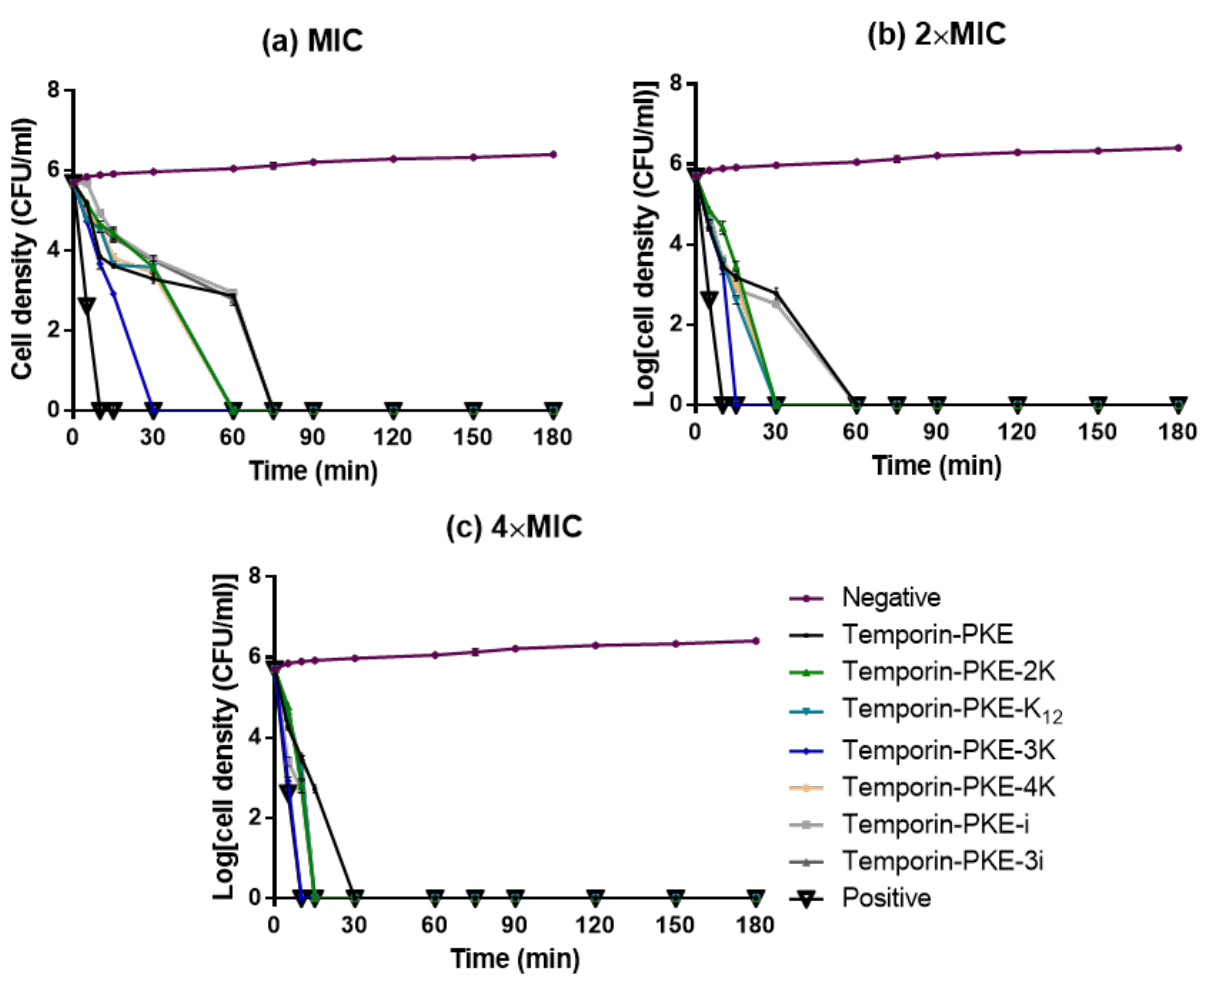
Figure 8. The kinetic time-killing curves of temporin-PKE and its analogues against S. aureus at the concentrations of ( a ) 1 × MIC, ( b ) 2 × MIC, and ( c ) 4 × MIC. Bacteria treated with MHB medium only and 20 µ g/mL norfloxacin were used as the negative and positive control, respectively. The error bar represents the SEM of the three replicates from three independent